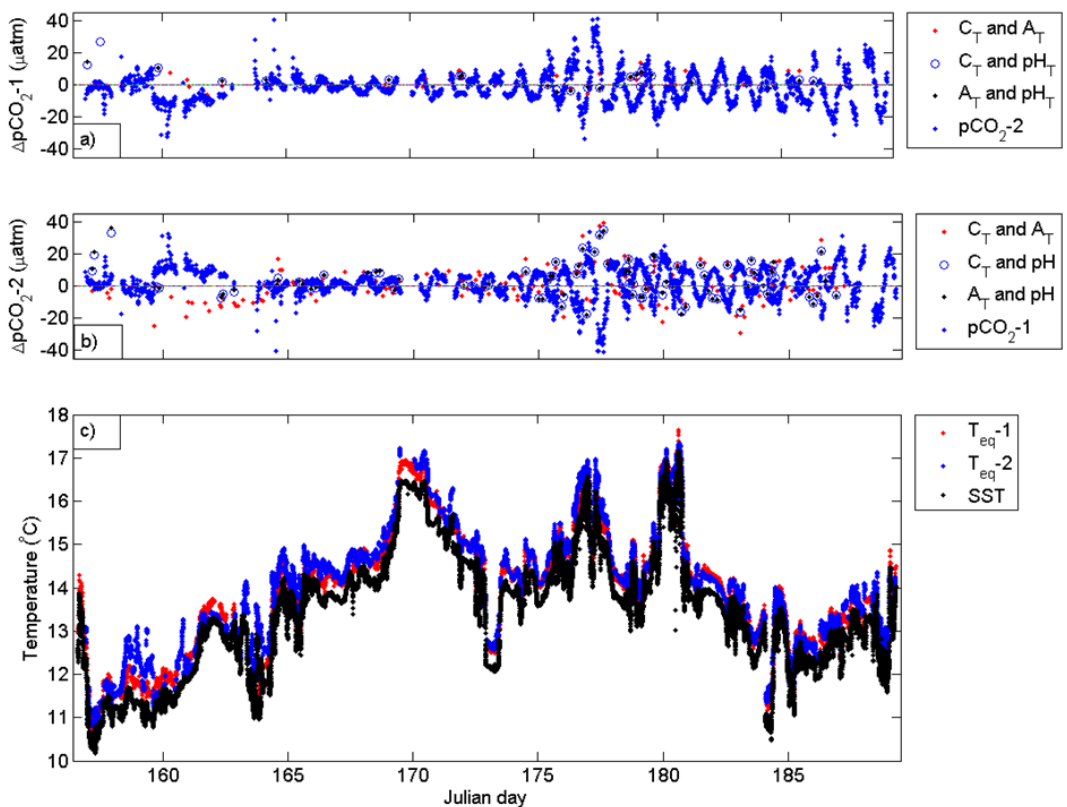
Figure 2. p CO 2 residuals of p CO 2 -1 (a) and p CO 2 -2 (b) compared to other measured or calculated p CO 2 values. Different symbols show different residuals: against p CO 2 from C T and A T (red plus symbols); against p CO 2 from C T and pH T (blue circles); against p CO 2 from A T and pH T (blue plus symbols); and against p CO 2 from the other measured p CO 2 (2 in a and 1 in a , blue dots). (c) In situ temperature, temperature of equilibrator 1, and temperature of equilibrator